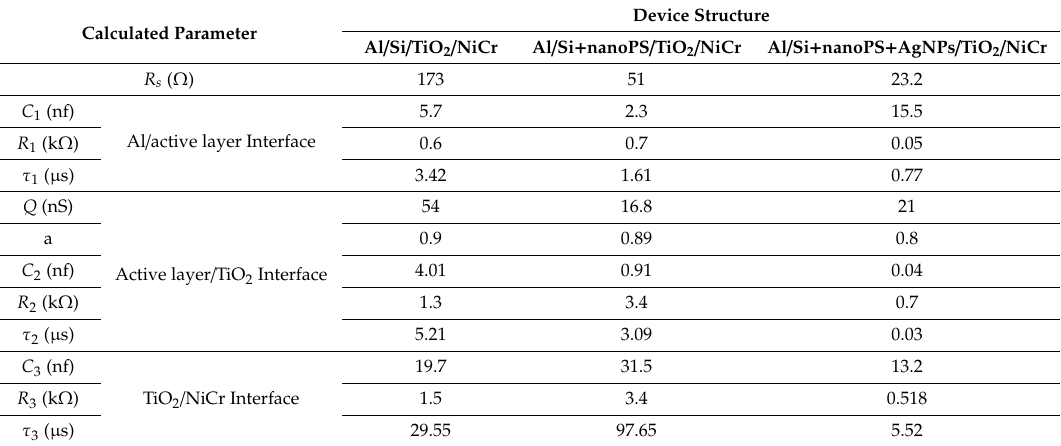
Table 2. Comparison between the electrical RC elements for the three Si-based MIS Schottky barrier diodes studied in this work. Device Structure Calculated Parameter Al / Si / TiO 2 / NiCr Al / Si + nanoPS / TiO 2 / NiCr Al / Si + nanoPS + AgNPs / TiO 2 /